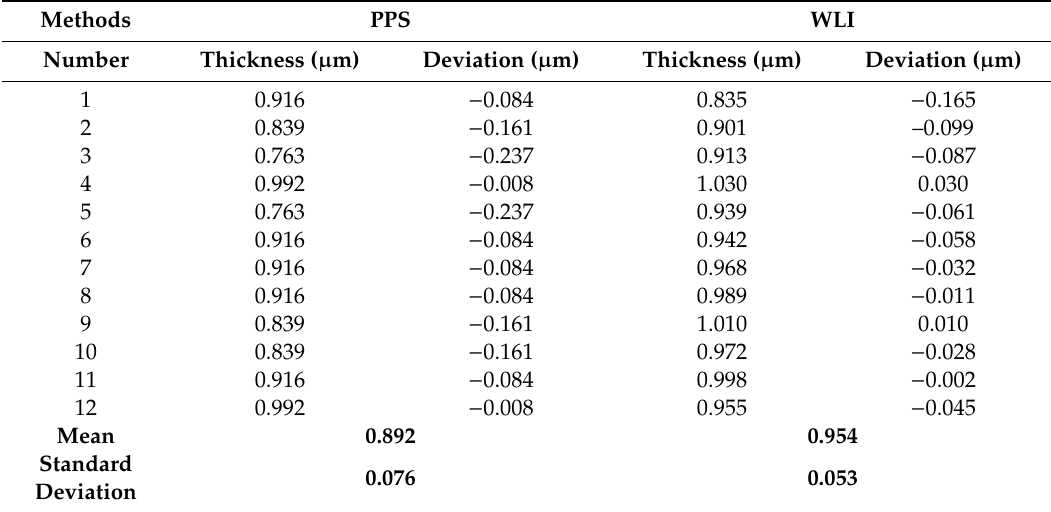
Table 1. PPS and white light interference (WLI) measurement results of germanium-based 1 µ m SiO 2 standard